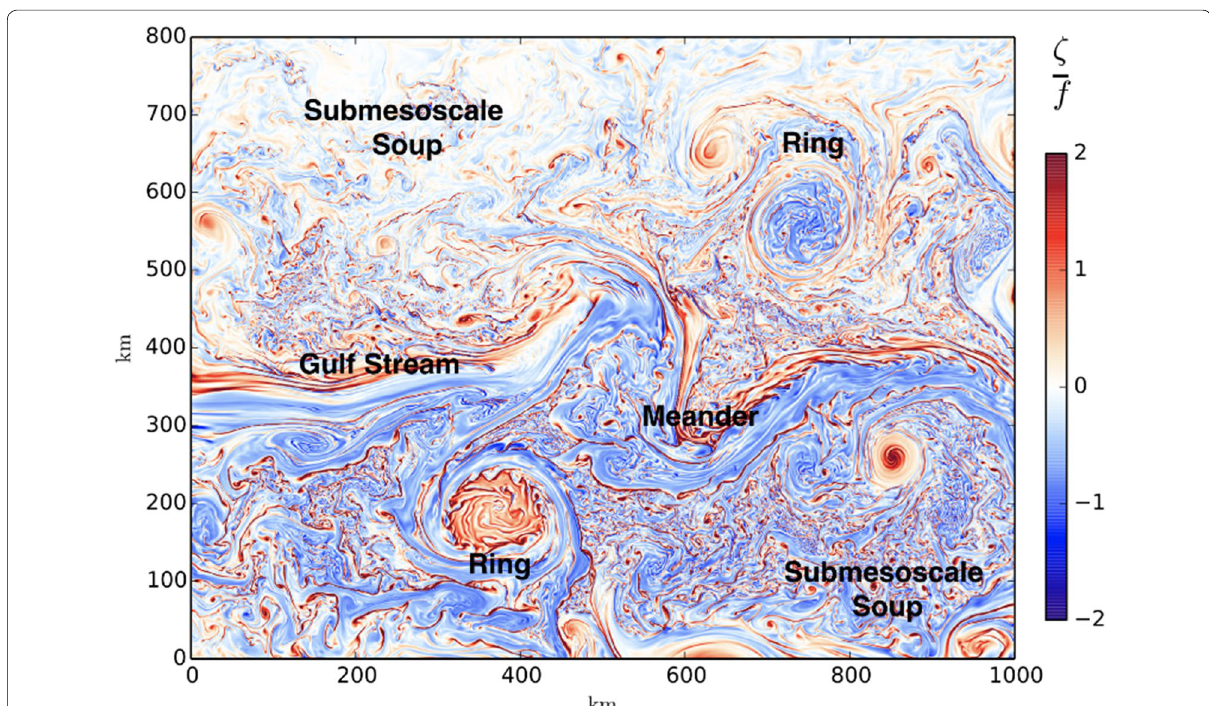
Fig. 6 Simulated offshore Gulf Stream. Vertical vorticity ( ζ = ∂ x v − ∂ y u ) normalized by f at the surface in the wintertime Gulf Stream after separation from the western boundary in a nested-subdomain simulation (Gula et al. 2015). Notice the meandering Gulf Stream in the center, the northern warm anticyclonic and southern cold cyclonic mesoscale Rings, and the nearly ubiquitous submesoscale features of many different types, including the typical open-sea “soup” away from strong mesoscale